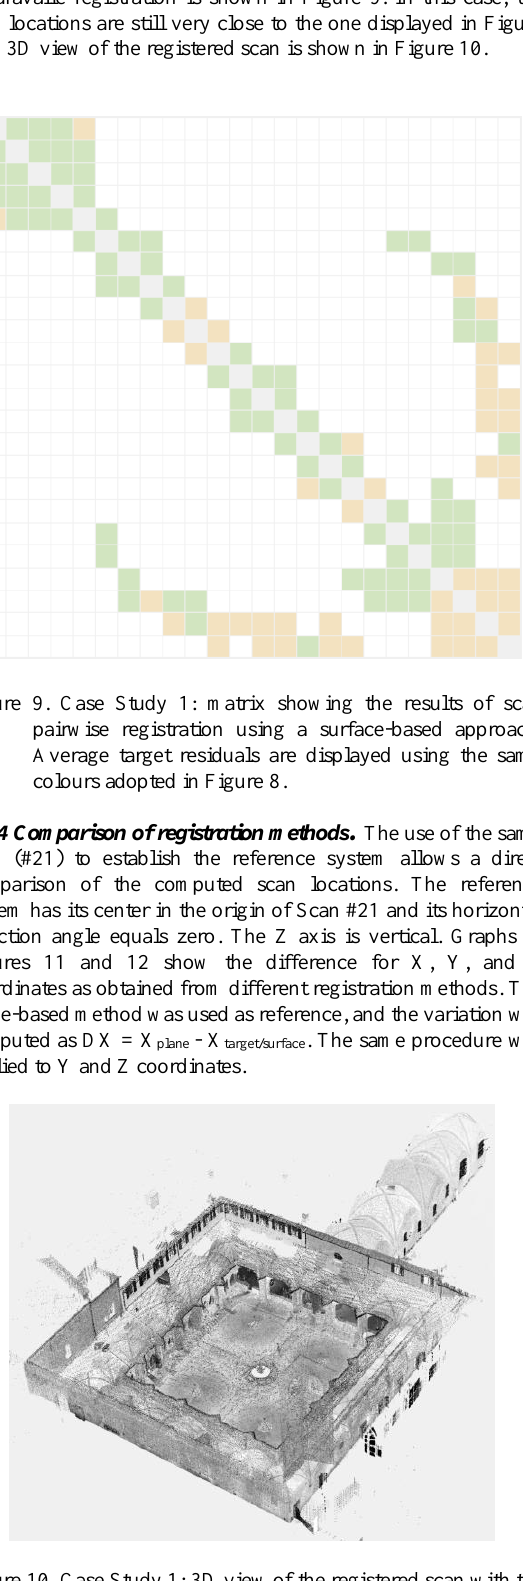
Figure 10. Case Study 1: 3D view of the registered scan with the surface-based